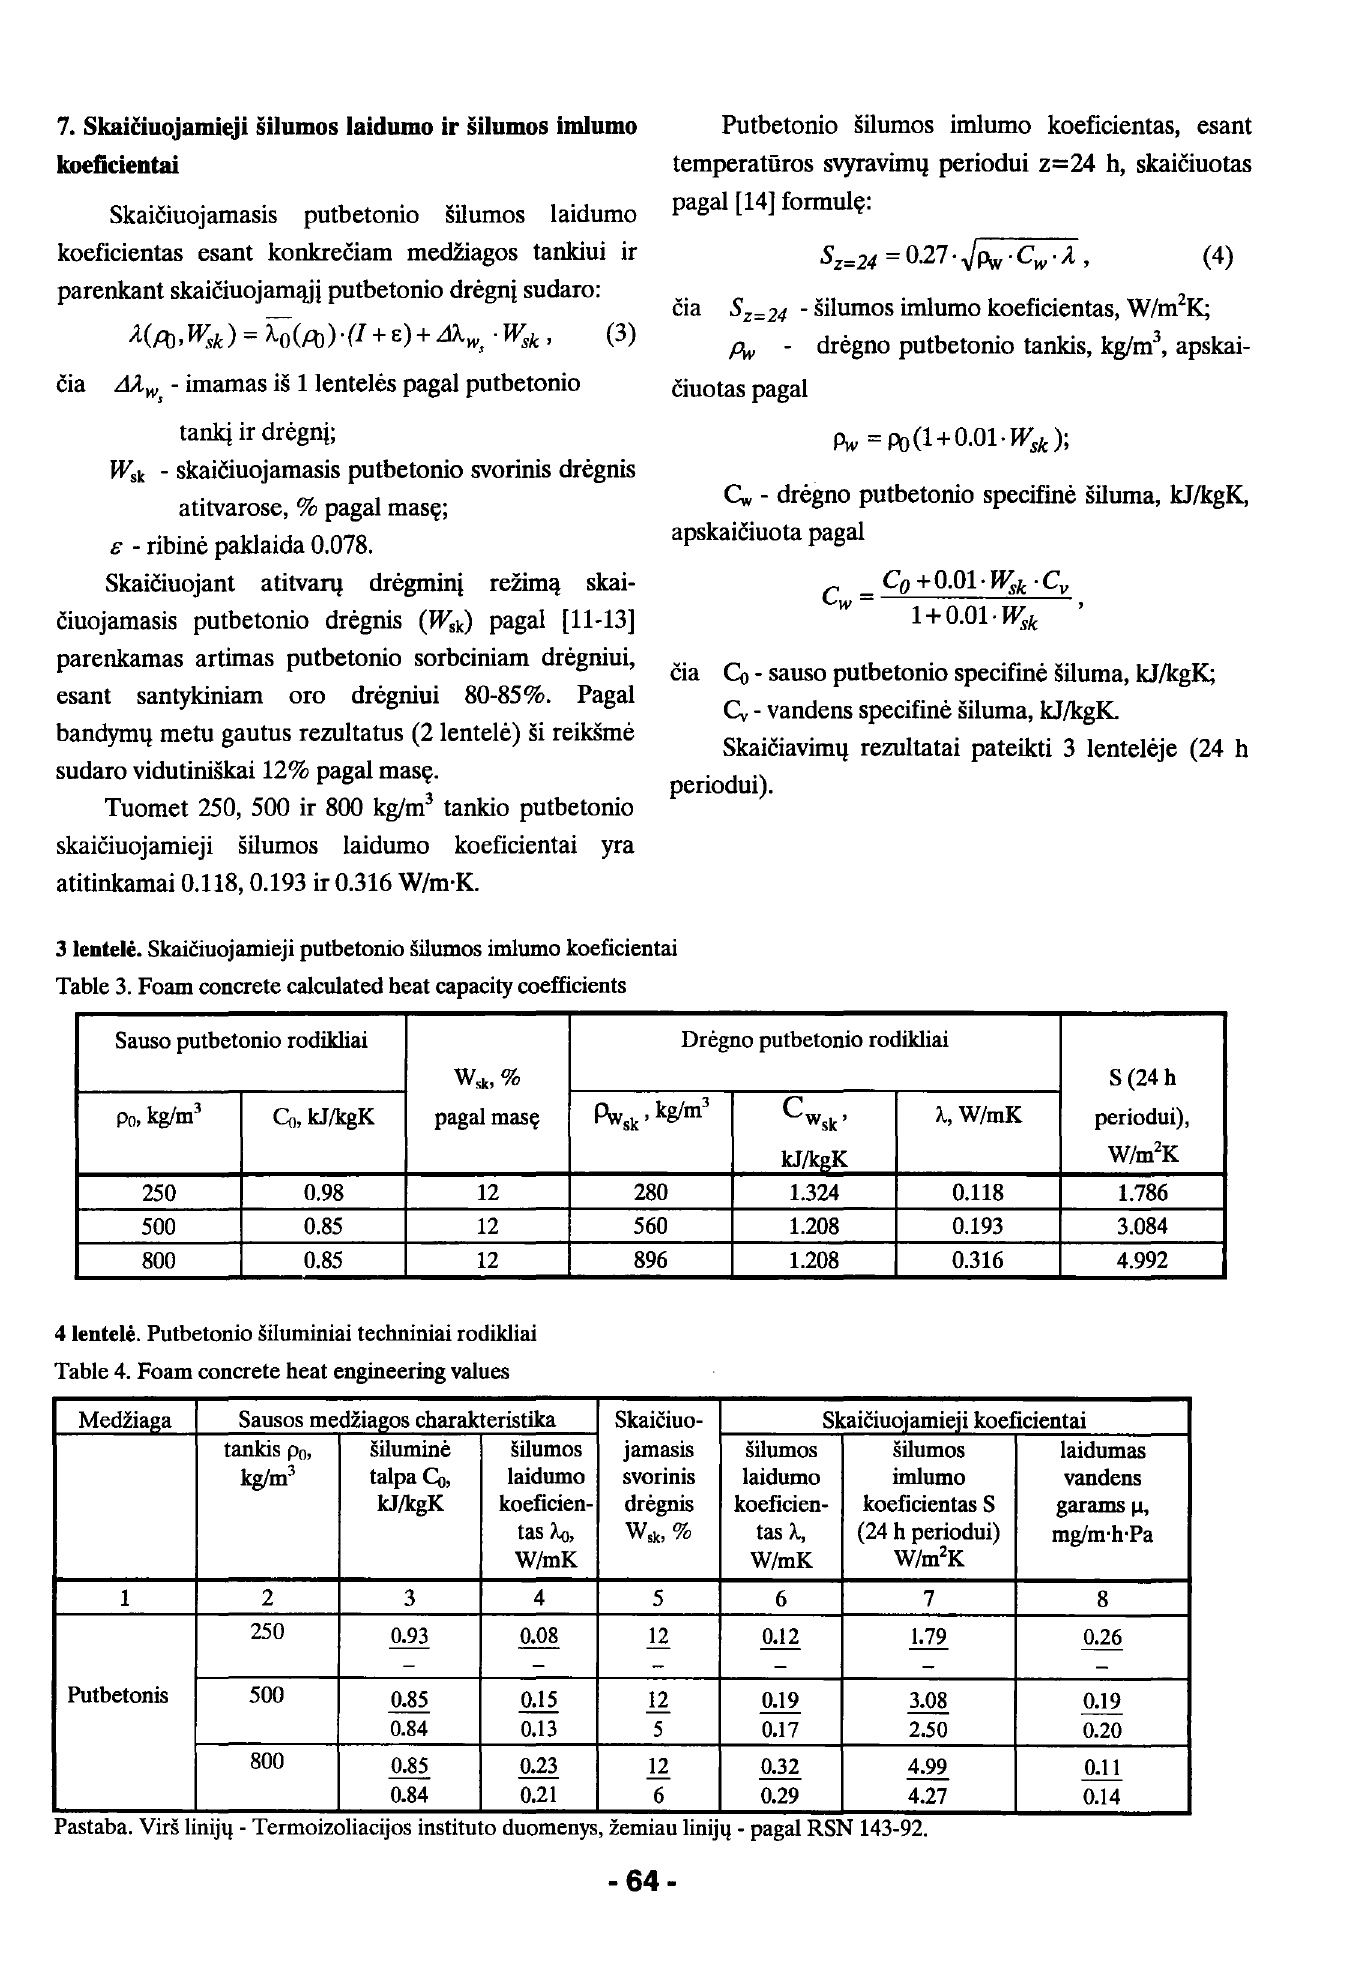
Table 3. Foam concrete calculated heat capacity coefficients